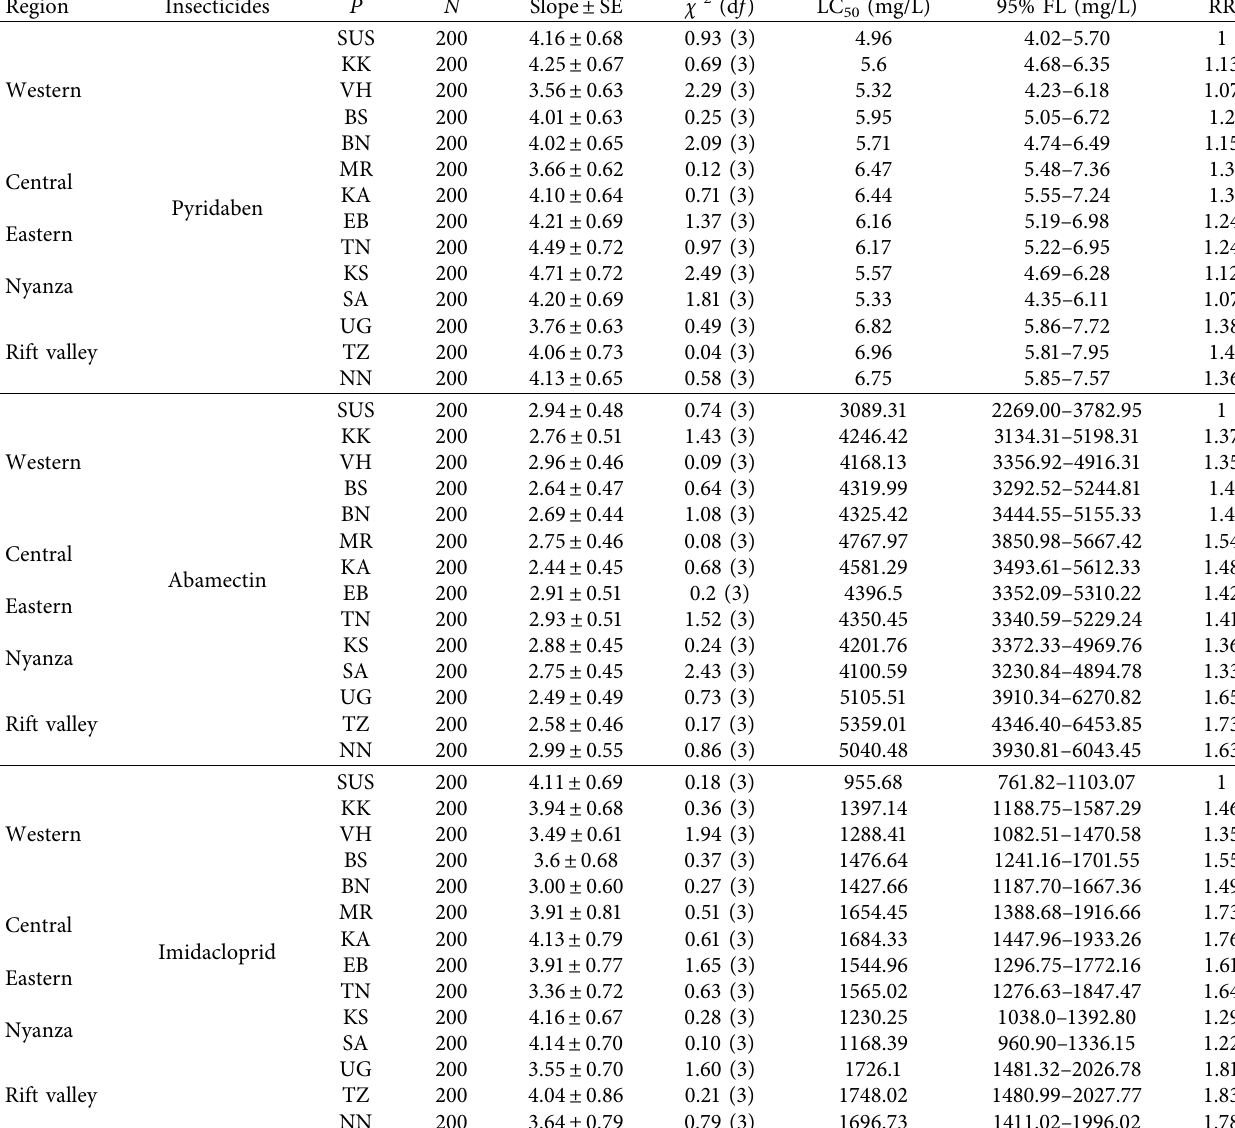
Table 4: Susceptibility of field populations of Spodoptera frugiperda to pyridaben, abamectin, and imidacloprid.